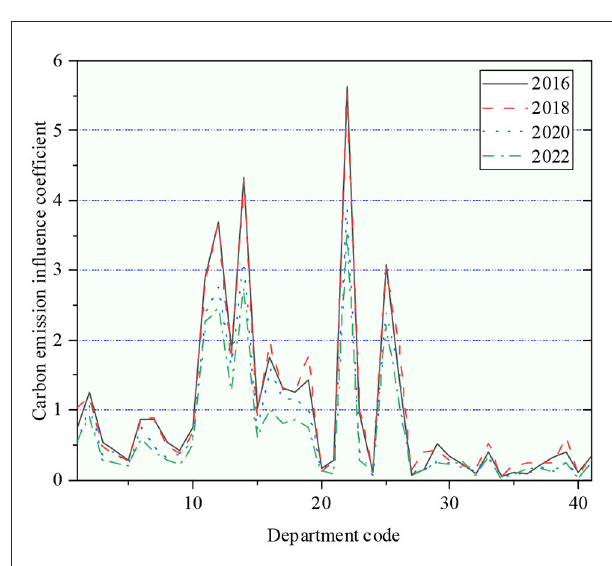
FIGURE10 The influence coefficient of CO 2 emission from 2016 to